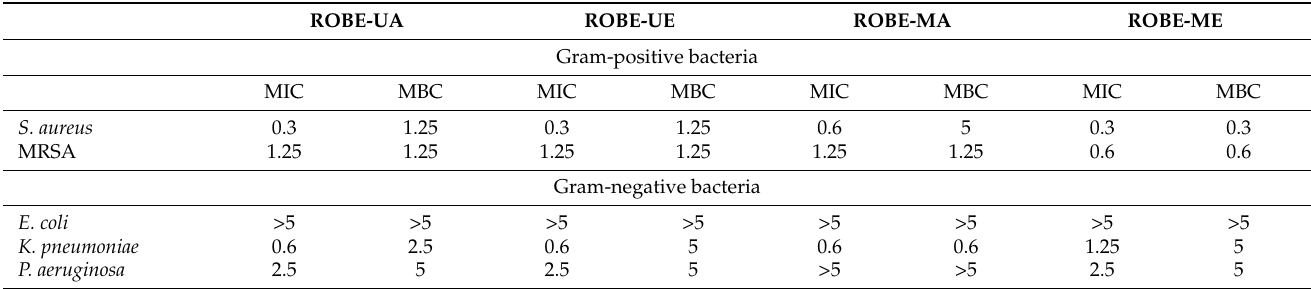
Table 2. Antibacterial activity (MIC and MBC in mg/mL) of the ROBEs.